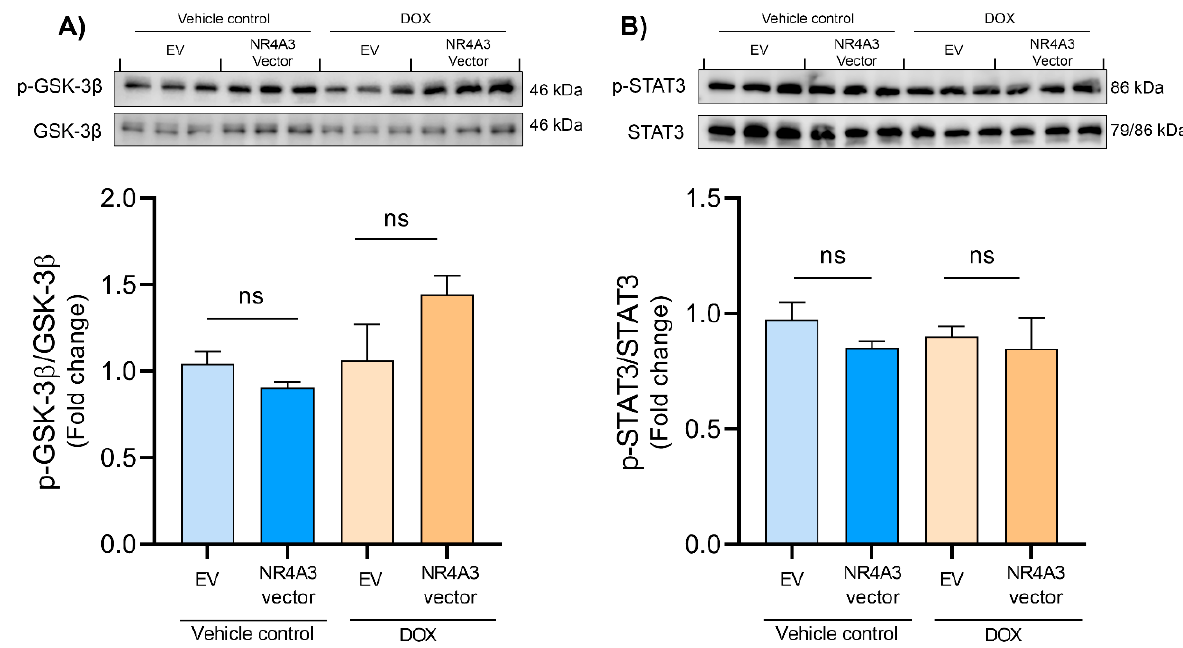
Figure 5. The levels of phosphorylation of GSK-3 β and STAT3 measured by Western blotting. The results in ( A , B ) show that treating the CMs with 5 µ M DOX for 12 h showed no effect on phosphorylation of GSK-3 β (Ser9) and STAT3 (Ser727), and neither on NOR-1 overexpression; the graphs in ( A , B ) are shown as mean with SD ( N = 3). ns = p >0.05 (not significant) .